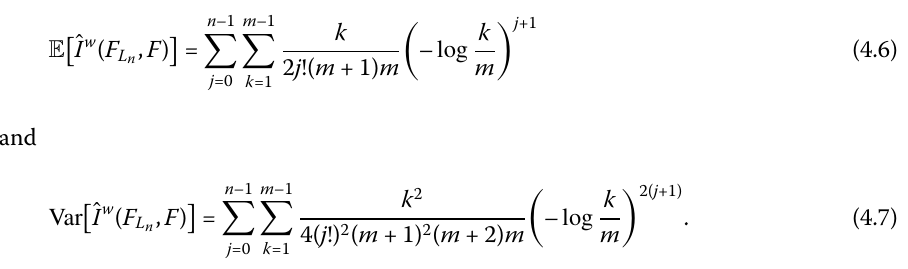
, F )] for Weibull distribution n